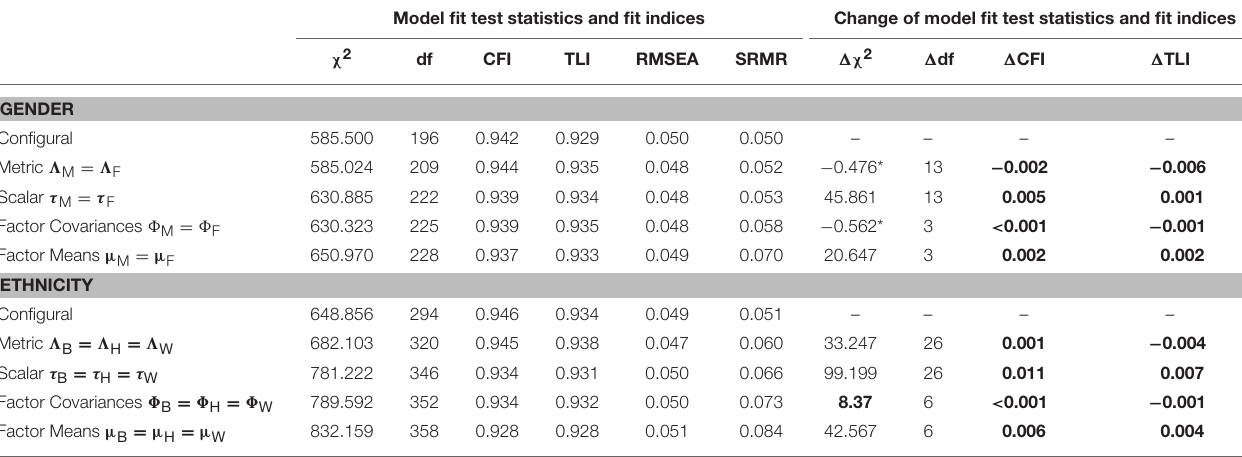
Bold font indicates the difference between two comparative models is statistically negligible. 3 , factor loading matrix; τ , item intercept vector; Φ , factor covariance matrix; µ , factor mean vector; subscripts indicate the groups of the measures collected; df, degrees of freedom; CFI, comparative fit index; TLI, Tucker-Lewis index; RMSEA, root mean square error of approximation; SRMR, standardized root mean square residual; M, male; F, female; B, Black; H, Hispanic; W, White. * Denotes the negative test statistic cannot be interpreted, and a Wald test of parameter constraints was examined instead.